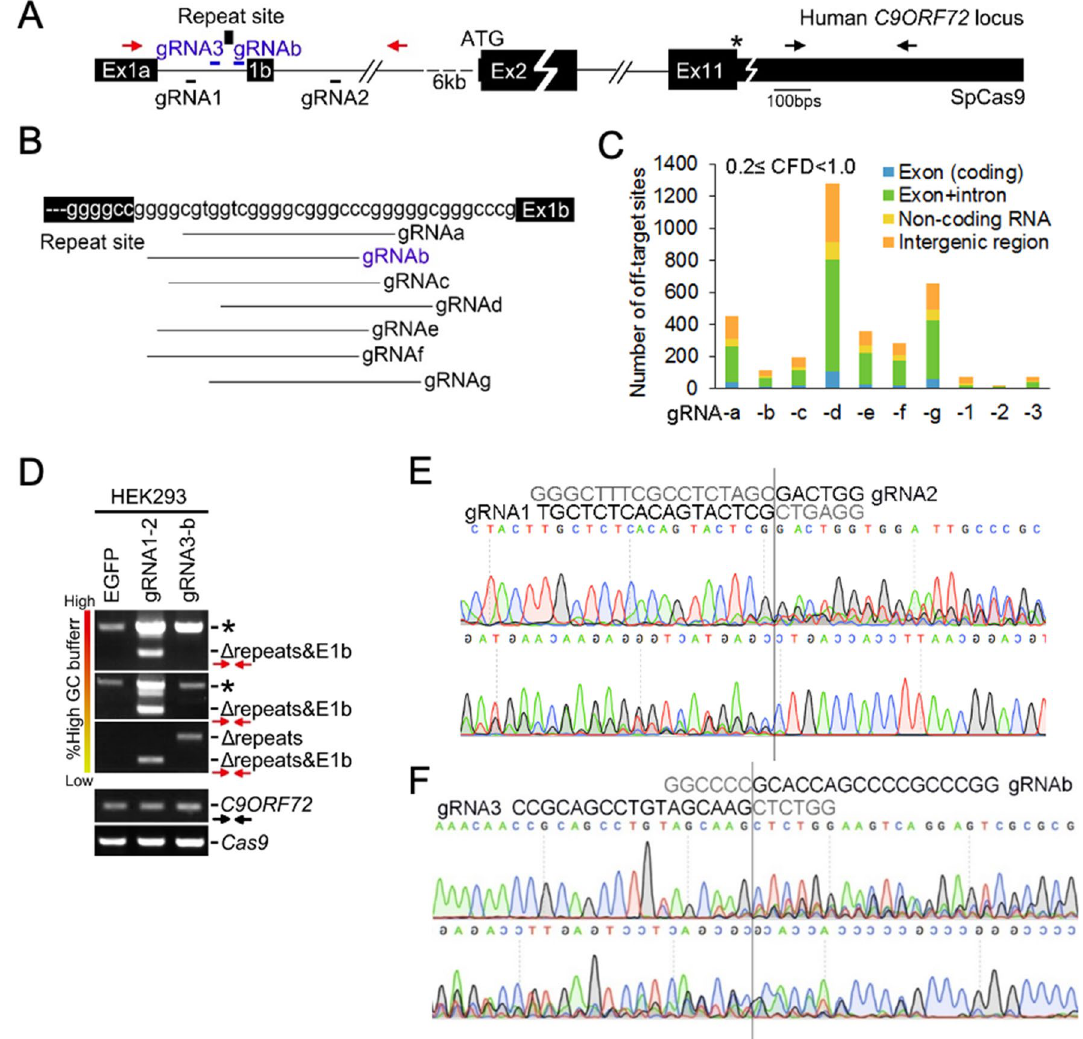
Figure 1. Our dual gRNAs remove the C9ORF72 repeat site in human cell. ( A ) The C9ORF72 genome structure (GRCh37/hg19) and our dual-gRNA design (gRNA1-2 pair or gRNA 3-b pair) for removal of the C9ORF72 repeat site. The gRNAs described here are SpCas9-based. The primers flanking the gRNA editing sites labeled as red arrows used for genotyping the removal. The primers in last exon (exon 11, Ex11) labeled as black arrows used for detecting C9ORF72. ( B ) All available gRNAs lie between the repeat site and exon 1b (Ex1b). The distance between the repeat site and exon 1b is 35bps. The gRNAb is in antisense orientation, and the rest of gRNAs are in sense orientation. ( C ) Off-target summary of gRNAs we examined by using an online gRNA design tool (https:// porta ls. broad insti tute. org/ gpp/ public/ analy sis- tools/ sgrna- design). The off-target details are shown in Supplementary Table 1. ( D ) Genomic DNA PCR for detecting the removal of repeat site by gRNA1-2 and gRNA3-b. The HEK293 cells constitutively expressing Cas9 were infected with the lentiviral control, gRNA1-2, and gRNA3-b, respectively (also see Supplementary Fig. 2). The repeat site deletion (ΔRepeats) or repeat site plus exon1b (E1b) deletion (ΔRepeats + E1b) appeared in cells infected with gRNA1-2 or gRNA3-b. Due to the high GC content of the DNA region we amplified, PCR amplicons containing the repeat site and its neighboring sequences (labelled as asterisk) did not appear in control group in the PCR condition with low amount of high GC buffer. High GC buffer condition: from red to yellow, usage of high GC buffer from high to low %. The amplicons of C9ORF72 last exon were used for PCR reaction control. The primers used here were illustrated in ( A ). ( E and F ) The repeat deletion bands (Δ) shown in ( D ) were applied for both forward and reverse Sanger sequencing. The editing site fusions took place upstream of the PAM (the protospacer adjacent motif, NGG)